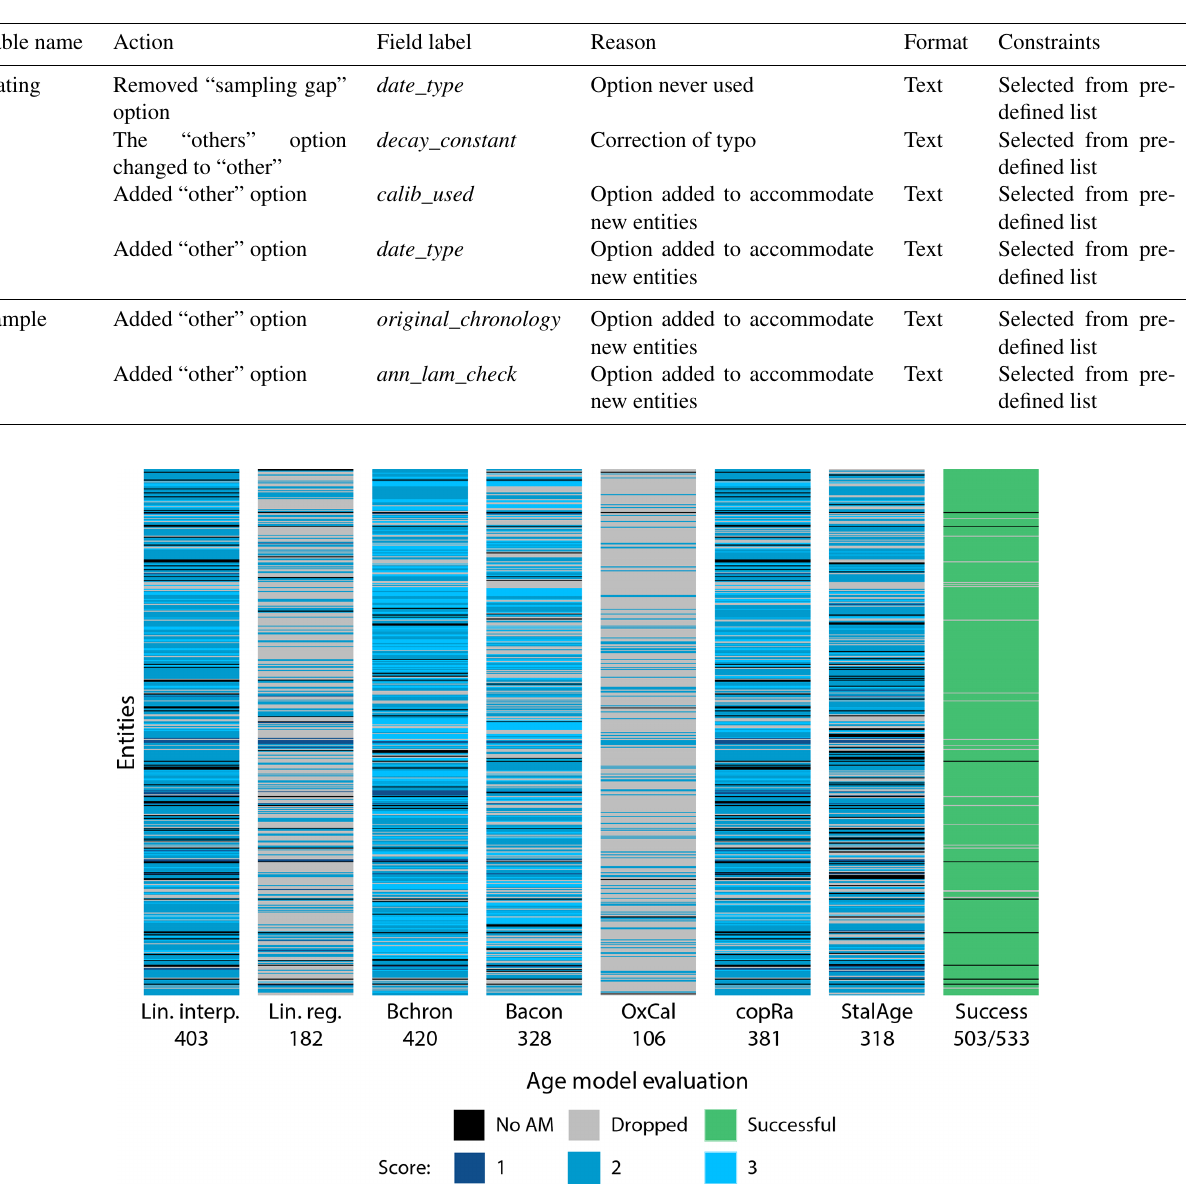
Table 3. Changes made to tables other than the sisal_chronology since the publication of SISALv1 (Atsawawaranunt et al., 2018a, b).